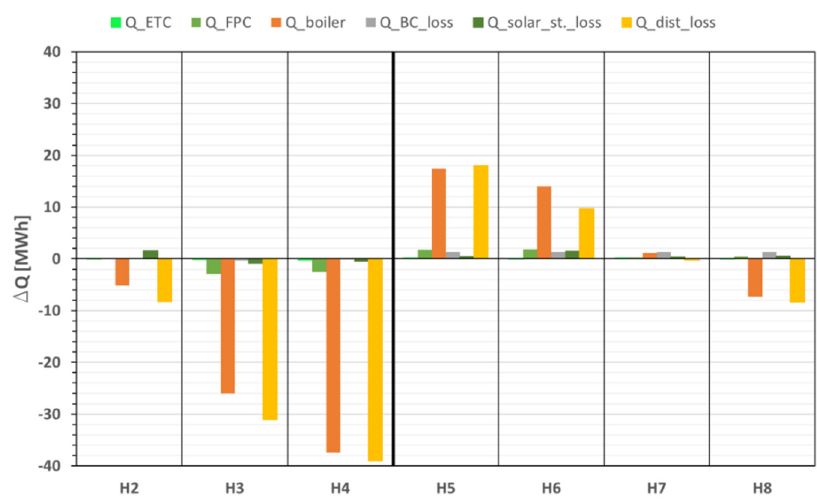
Figure 10. Energy balance difference–absolute changes in supplied and lost energy compared to the reference variant (H1) for the variants of the hybrid distribution concept. The bold line indicates a change in the manufacturer of PEX pipes; H1–H4 employs PEX M2, while H5–H8 employs M1 and M3—See Table 6 for an overview.